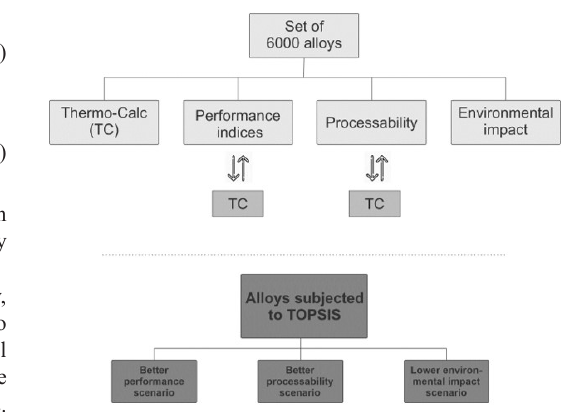
Figure 1. Sequence of computations and analyses completing the methodology for the selection of the 6000